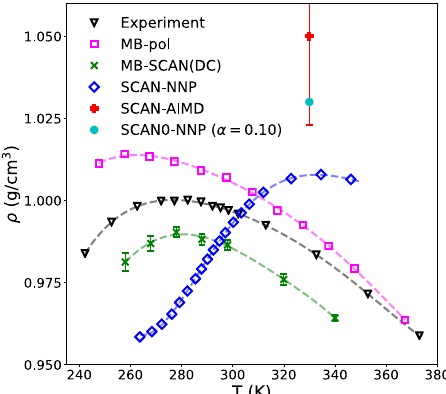
Fig. 5 Density of liquid water. Temperature-dependence of the density of liquid water at 1 atm calculated from classical NPT simulations carried out with MB-SCAN(DC) along with the results from SCAN-AIMD 43 , SCAN- NNP 92 , and SCAN0-NNP (with 10% HF exchange) 52 simulations. The MB- pol results are from ref. 78 , while the experimental data are from the NIST Chemistry WebBook 124 . Error bars for the MB-SCAN(DC) results represent 95% con fi dence